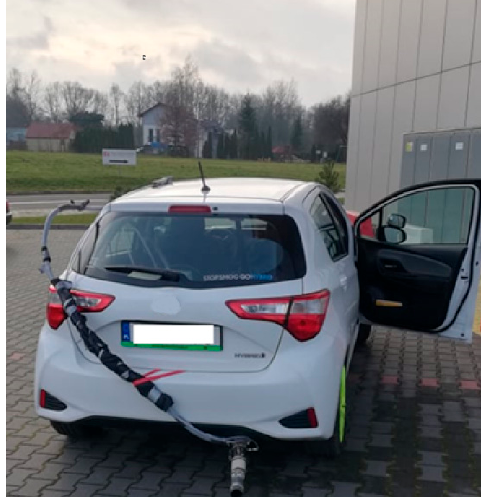
Figure 2. View of a PEMS-equipped vehicle used for road testing.